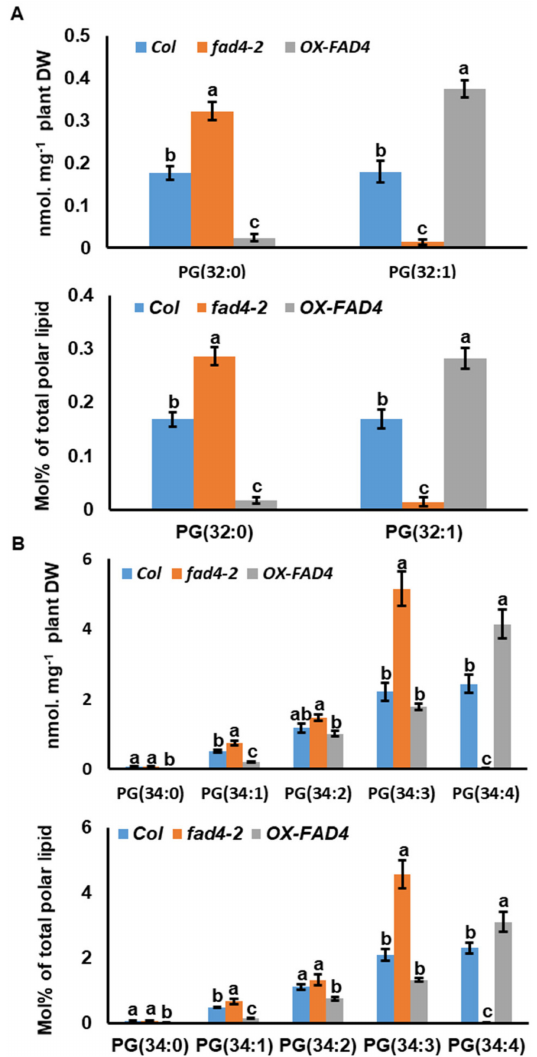
Figure 5. PG (32) and PG (34) contents and Mol % distribution from total polar lipids of WT, fad4-2 , and OX-FAD4_2 plants. ( A ) PG (32) contents (upper panel) and Mol % distribution from total polar lipids (lower panel). ( B ) PG (34) contents (upper panel) and Mol % distribution from total polar lipids (lower panel). Data were expressed as mean ± standard error (n = 5). Different letters within the same molecular species represent statistically significant